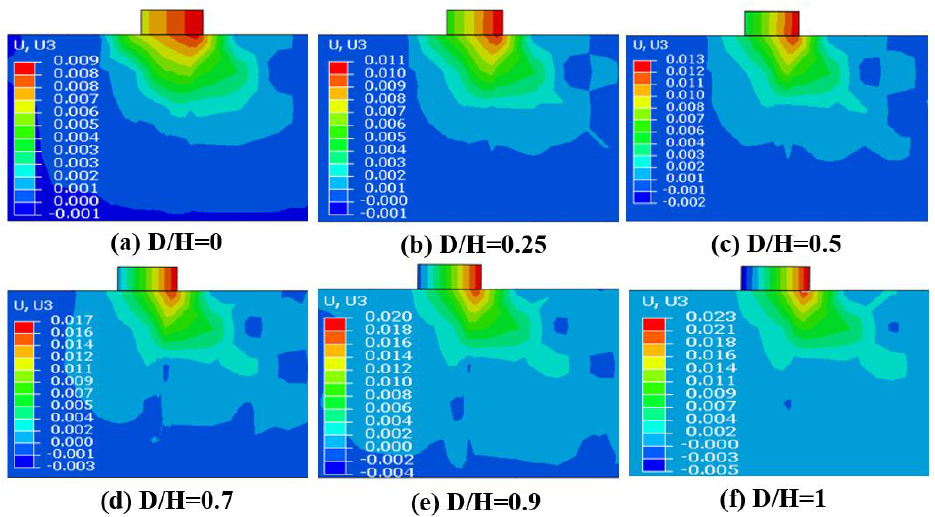
Figure 20. Soil deformation diagram at different mooring heights of gravity anchors.